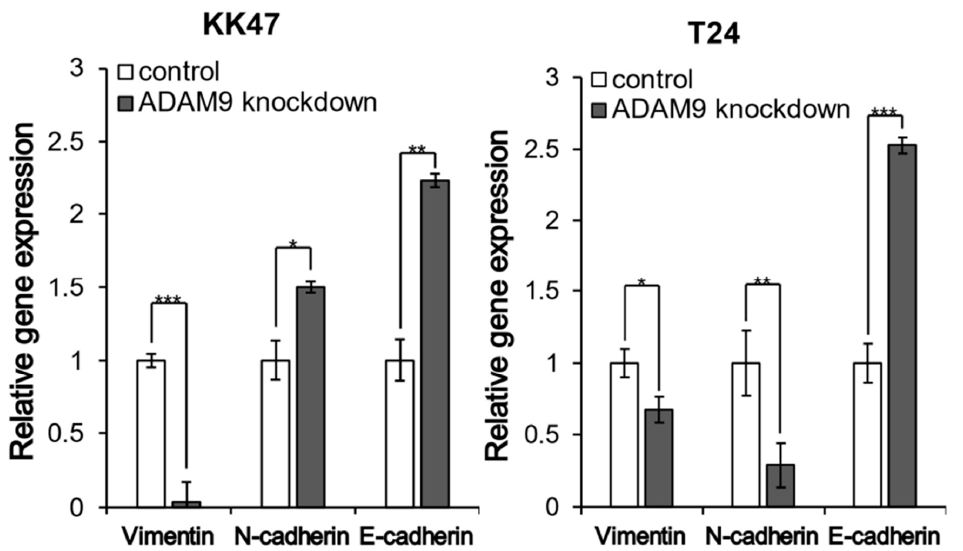
Figure 5. Gene expression of EMT-related proteins. Association between ADAM9 and EMT was investigated by RT-qPCR. The expressions of Vimentin, N-cadherin, and E-cadherin were compared in control and ADAM9 knockdown KK47and T24 cells. In KK47, the expression of vimentin significantly decreased and N-cadherin and E-cadherin significantly increased with ADAM9 knockdown ( p < 0.05). In T24, the expression of Vimentin and N-cadherin significantly decreased and E-cadherin significantly increased after ADAM9 knockdown ( p < 0.05) (* p < 0.05, ** p < 0.01, *** p < 0.001). Table 2. Row and calculated data using the double delta method (average).